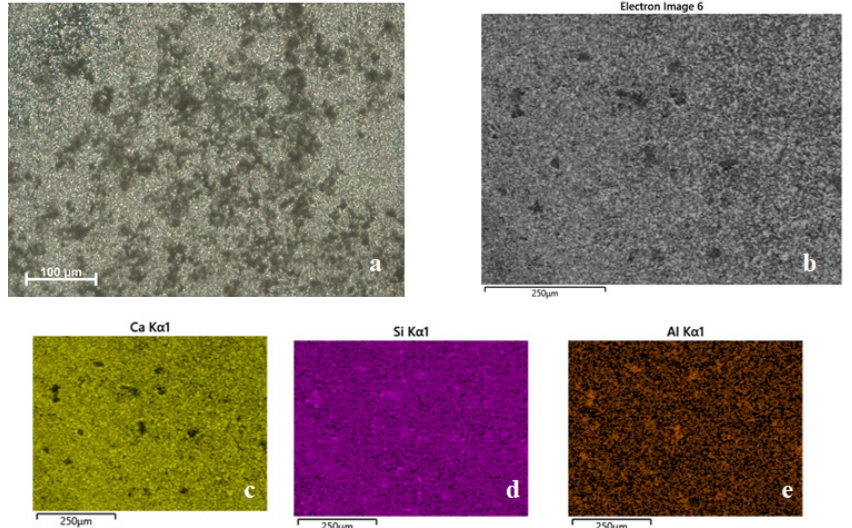
Figure 10. Microphotographs of small dark inclusions in the binder of a bedding mortar of the Palazzo Davanzati (Florence, 14th century); ( a ) under PLM, xpl; ( b ) BS image of a particular of this binder portion in which areas with different grey tones can be observed; ( c ) SEM EDS map of Ca; ( d ) SEM EDS map of Si; and ( e ) SEM EDS map of